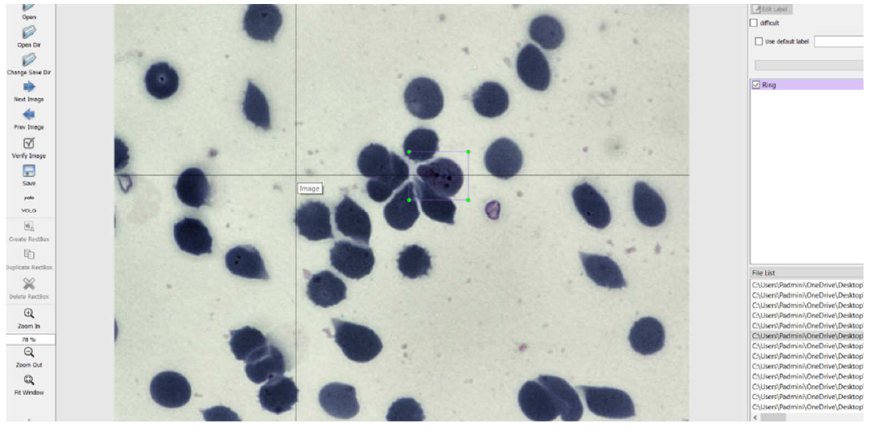
Figure 5. LabelImg User Interface.